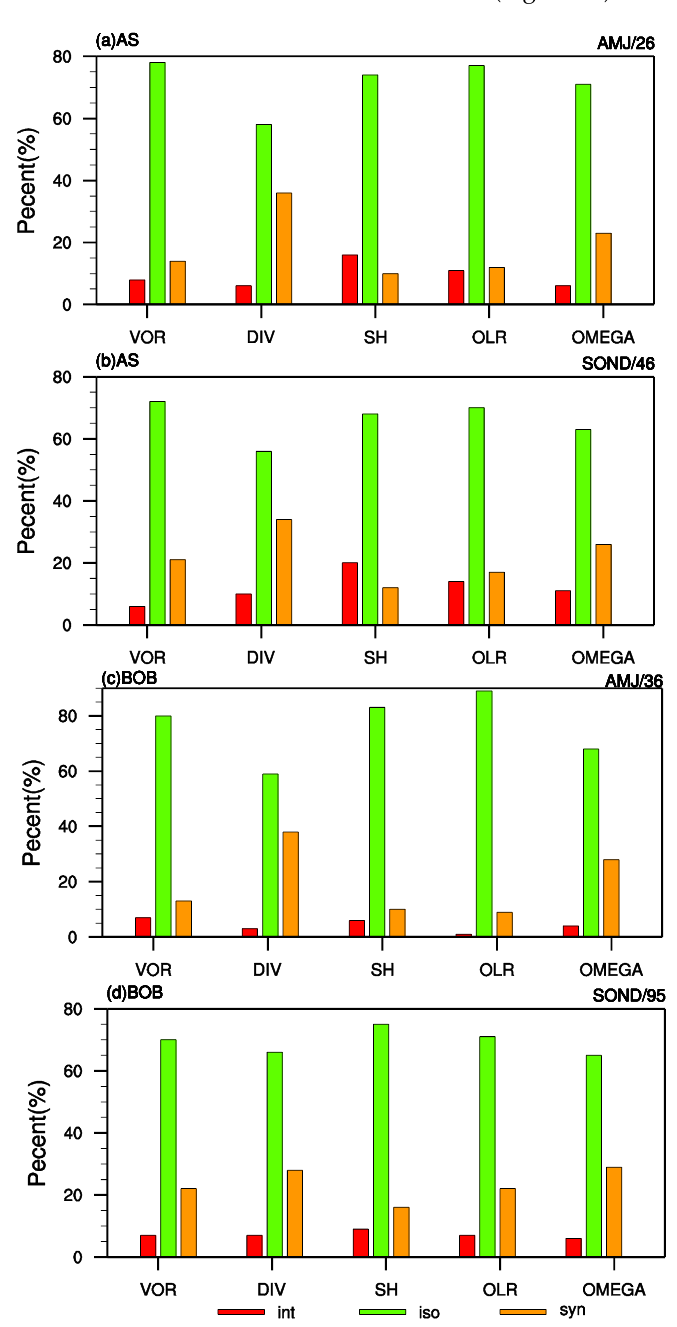
Figure 9. Similar to Figure 6a, except over the ( a , b ) AS and ( c , d ) BOB during ( a , c ) AMJ and ( b , d ) SOND during the period 1979–2020. The four digit numbers at the top right indicate the TC formation number in the respective region and period.